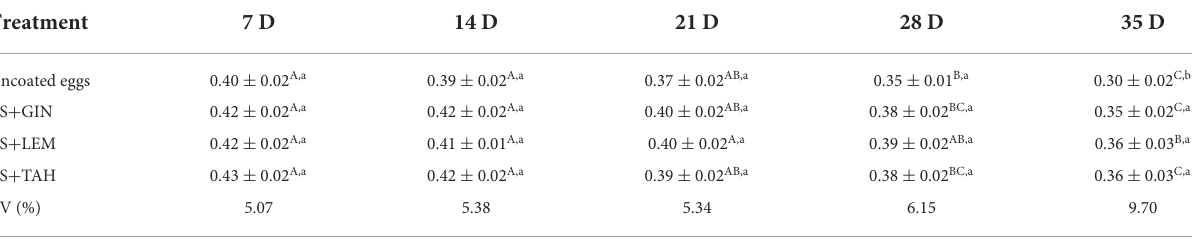
TABLE 2 Yolk index (YI) of the different treatments during the 35 days of storage at 20 ◦ C. Treatment